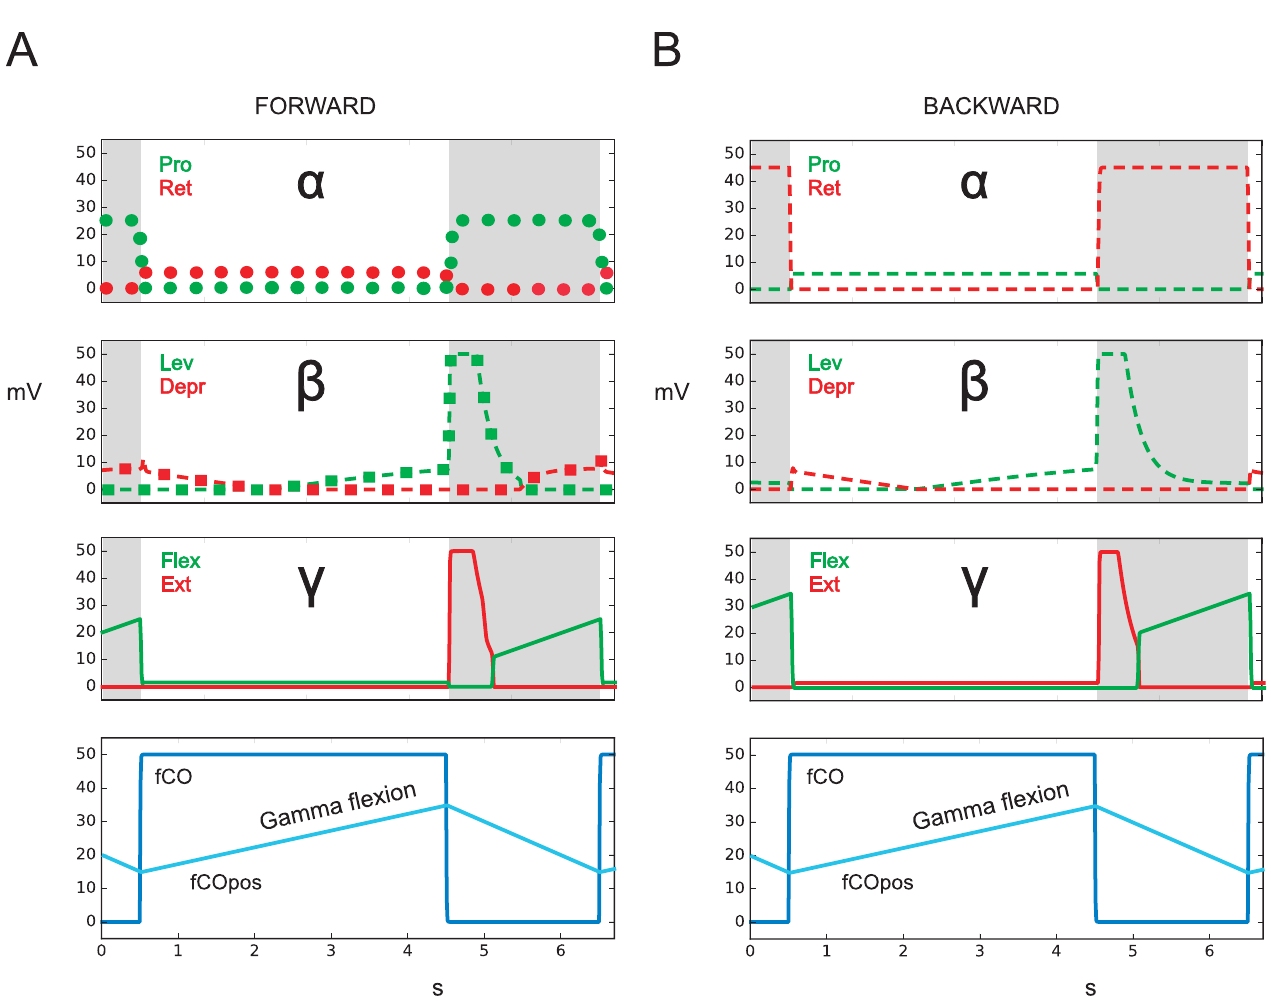
Fig 3. Active reaction. fCO stimulus (elongation) drives flexor or extensor as observed in [26], the levator or depressor as observed in (Hess, Bu¨schges 1999, see sect 3.3, red or green dashed squares), and the protractor or retractor as observed by Ba¨ssler (1986), red or green dots. Below: activation of fCO stimulus (blue). A) state: forward walking. B) state: backward walking. Abscissa: time (s), ordinate (mV). Dashed lines: simulation data for which no biological results are given. Dotted lines: results from [24]. fCOpos (light blue line) indicates fCO apodeme position, Gamma flexion shows direction of movement. fCO: input to unit swing or unit